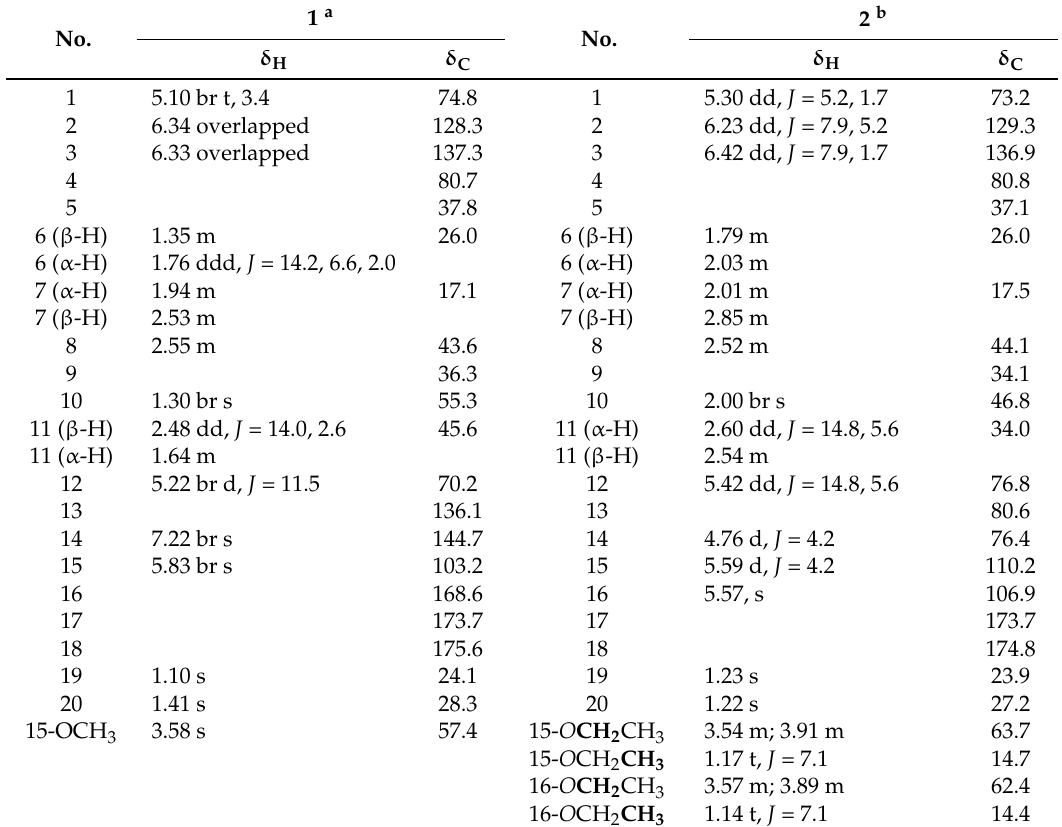
Table 1. 1 H- (400 MHz) and 13 C- (100 MHz) NMR spectral data of compounds 1 and 2 .